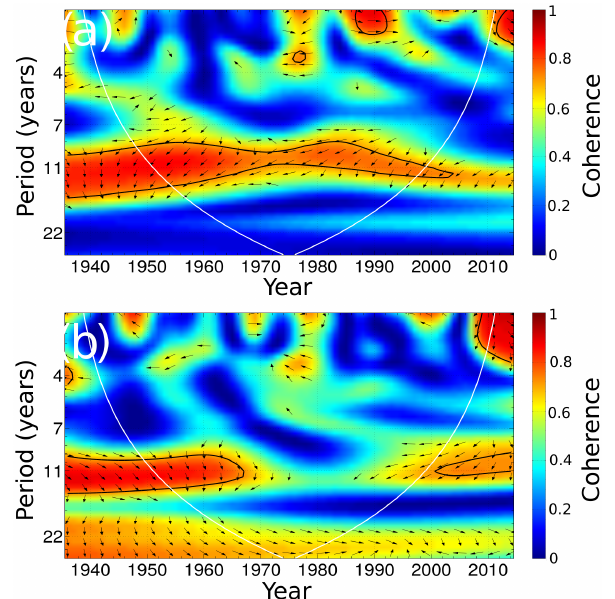
Figure 5. Wavelet coherence spectrum between annual average temperature for (a) TOR and SN and (b) IRA and SN. The colors indicate the coherence coefficient: black arrows represent the phase angle between the temperature and the sunspot cycle; black lines limit areas within which coherence values have a confidence level of 95% against red noise; the white line indicates the area of the cone of influence, below which edge effects cannot be